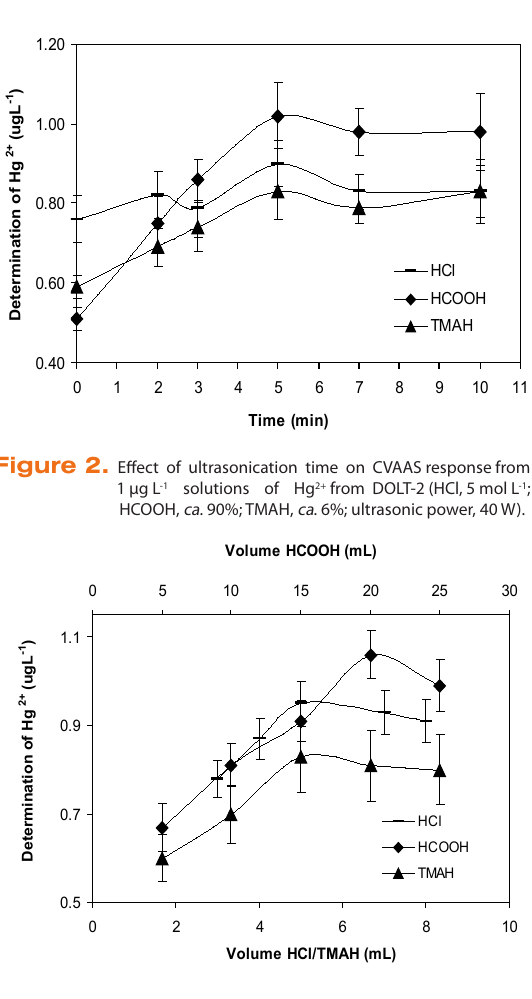
Figure 5. Effect of concentration of SnCl on CVAAS response from 2 1 µg L -1 solutions of Hg 2+ from DOLT-2 (HCl, 5 mol L -1 ; HCOOH, ca. 90%; TMAH, ca. 6%; ultrasonication time, 5 min; ultrasonic power, 40